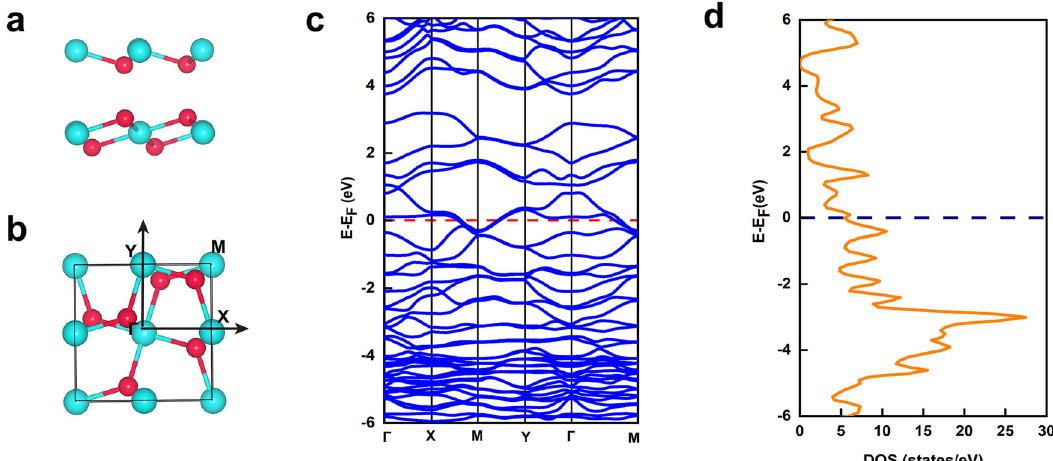
Fig. 7 DFT calculation of defective PdSe 2 . a Unit cell (side view) of bilayer PdSe 2 with Se vacancy on the top layer (Se TLU ). b Unit cell (top view) of defective 2L PdSe 2 showing the high symmetry K-points in the Brillouin zone. c Electronic band structure, and d DOS plot of defective 2L PdSe 2 using HSE06 functional showing metallic behavior. The Fermi level has been set to zero and indicated by the dashed